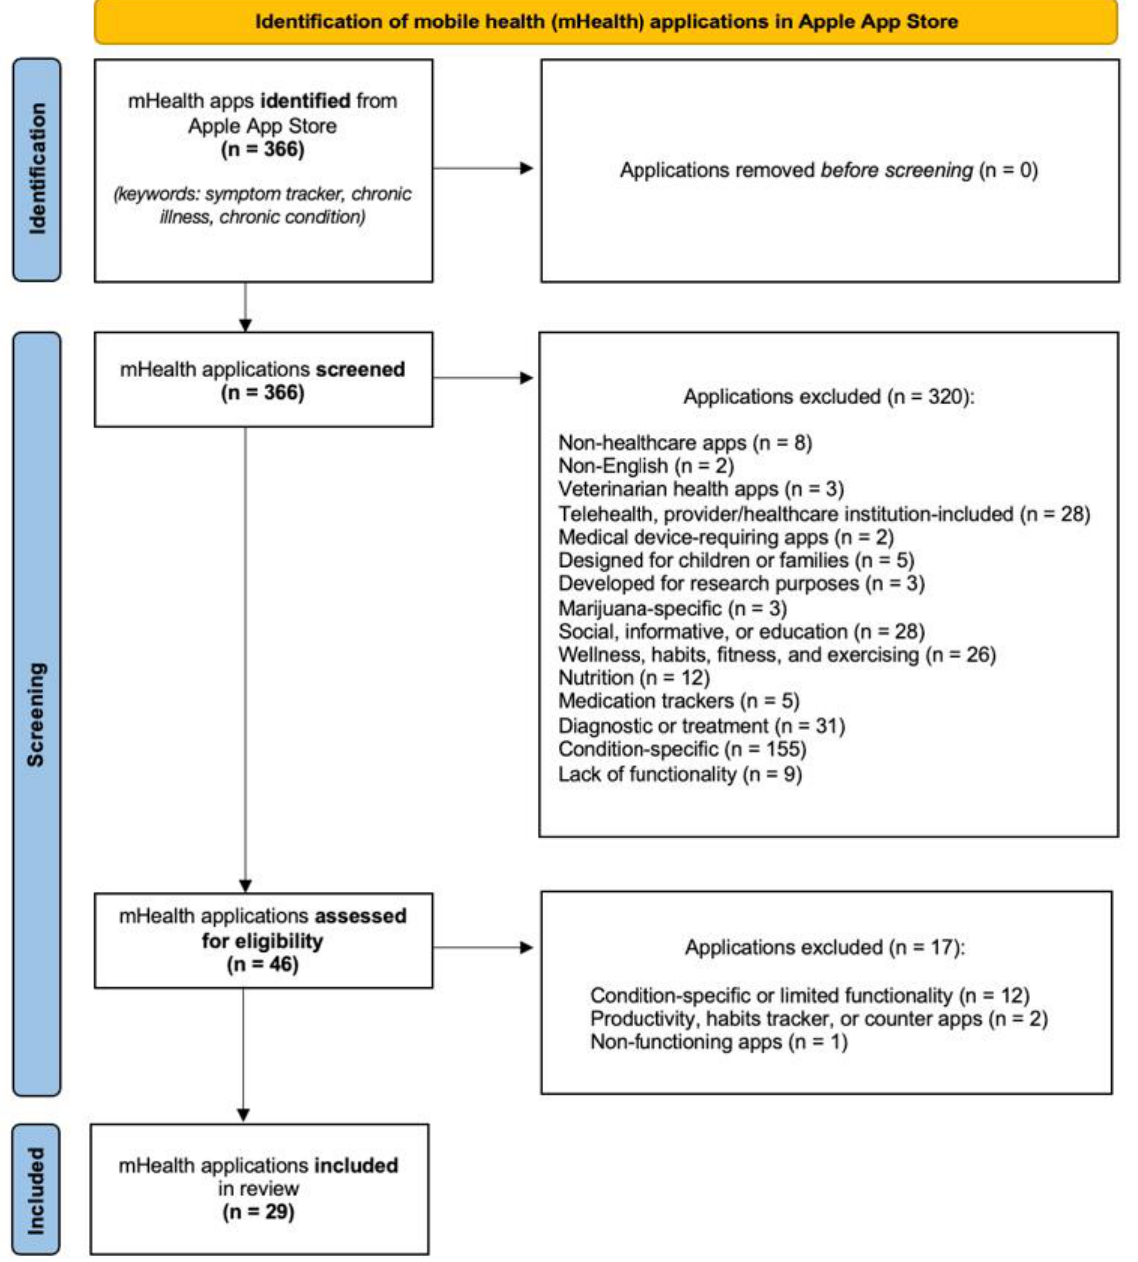
Figure 1. PRISMA flow diagram for systematic mobile health (mHealth) applications search con- ducted in Apple App Store.